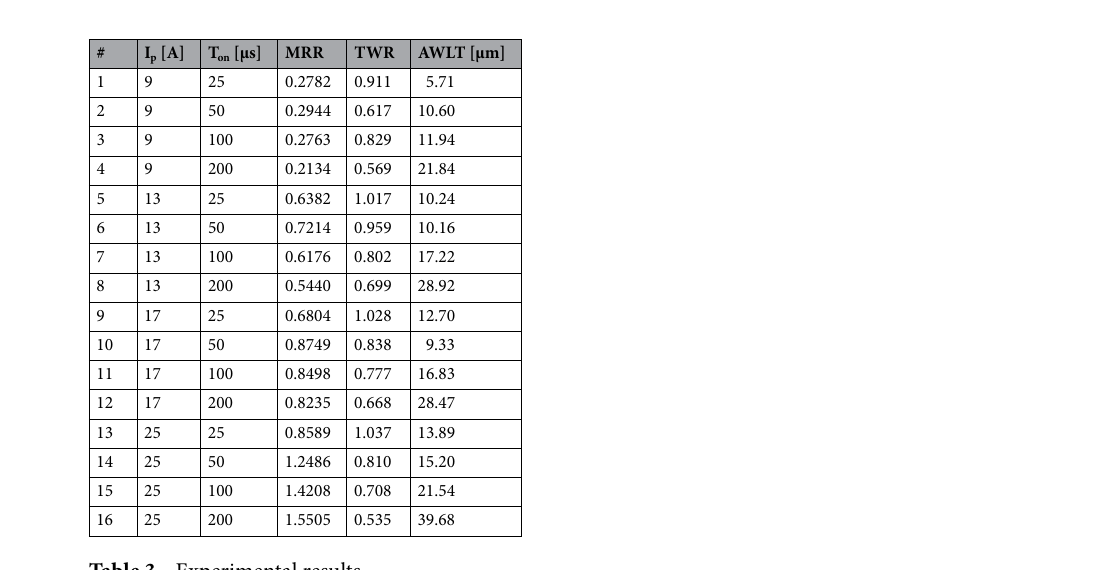
Table 3. Experimental